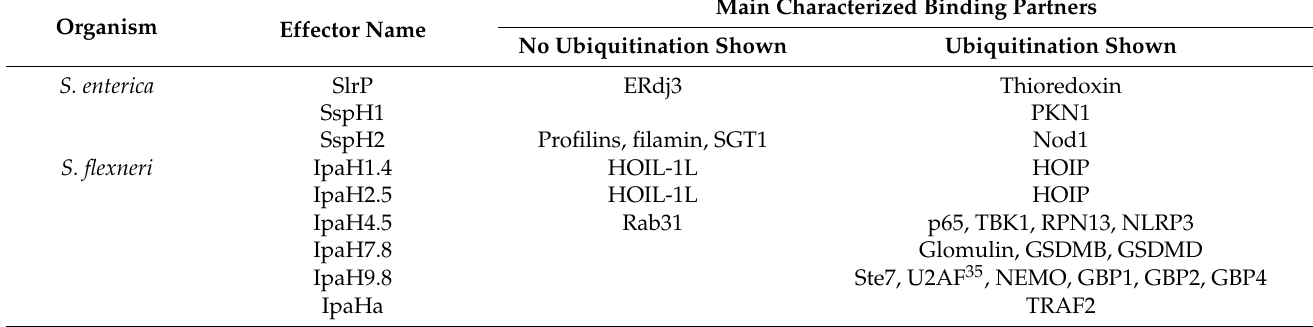
Table 2. Host targets of NEL T3SS